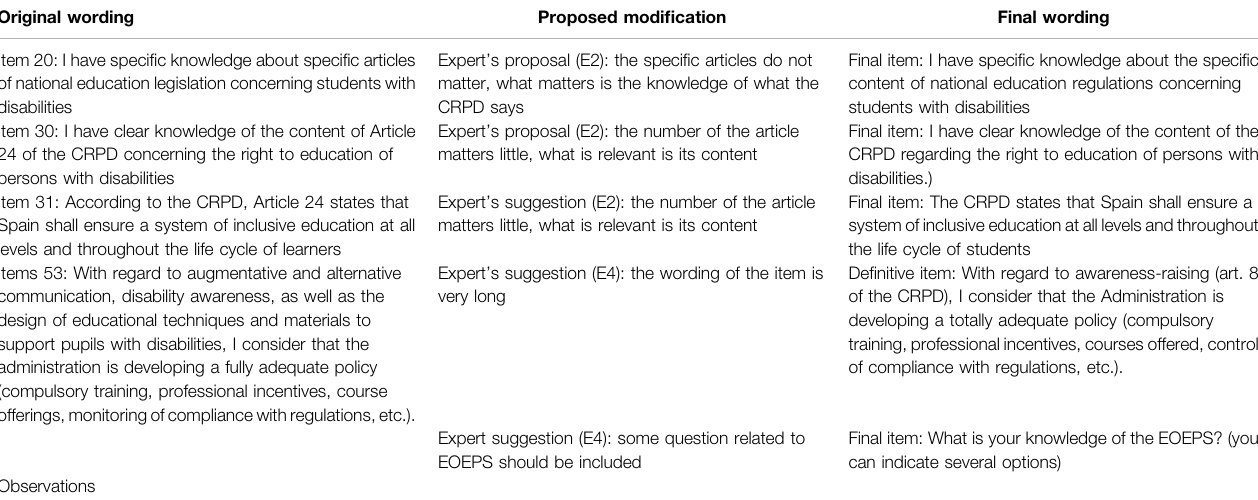
TABLE 4 | Experts ’ proposal for the modi fi cation of items. Original